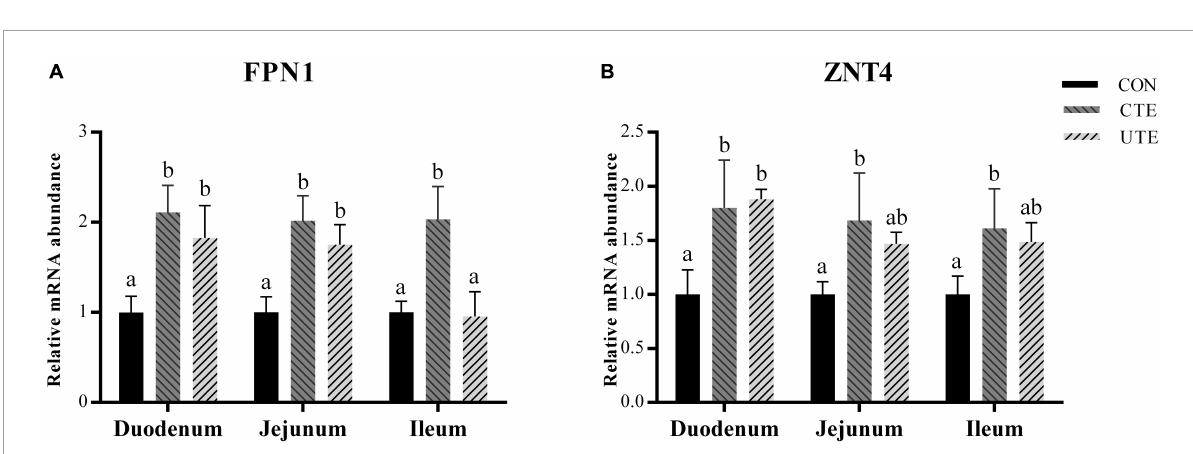
FIGURE3 Effects of coated and uncoated trace elements on the relative gene expression of ferroportin 1 ( FPN1 , A ) and zinc transporter 4 ( ZNT4 , B ) in small intestine. CON, sheep fed with the basal diets; CTE, sheep fed with the basal diets plus 400 mg/kg coated trace elements; UTE, sheep fed with the basal diets plus an equal amount of trace elements in uncoated form. Data are represented as mean and standard error and with different small letter superscripts mean significantly different ( P < 0.05), n = 4.